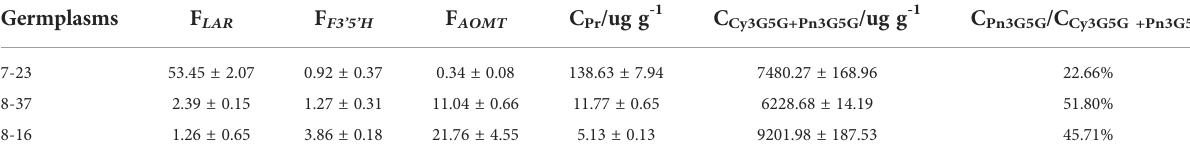
TABLE 2 FPKM values (F) of three DEGs and contents (C) of related metabolite.